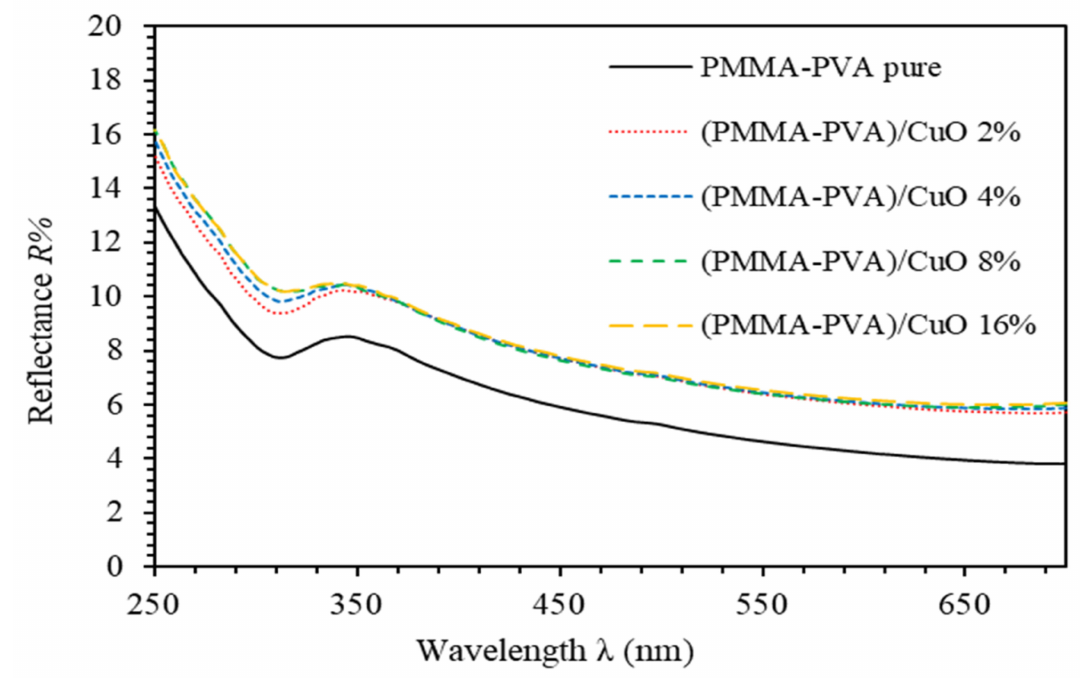
Figure 2. Reflectance spectra of PMMA–PVA/CuO nanocomposite thin films as a function of wavelength containing various CuO NPs